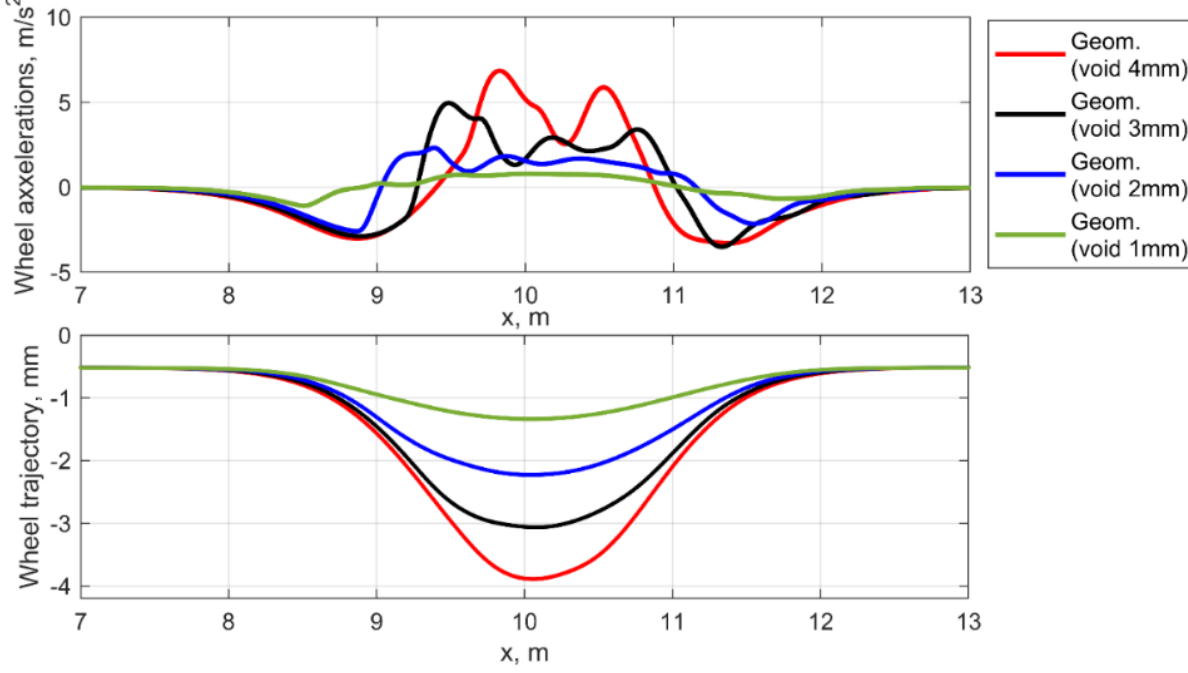
Figure 8. Simulated wheel accelerations in the geometric irregularity.